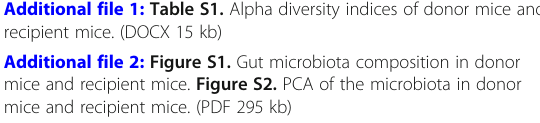
Additional file 2: Figure S1. Gut microbiota composition in donor mice and recipient mice. Figure S2. PCA of the microbiota in donor mice and recipient mice. (PDF 295 kb)